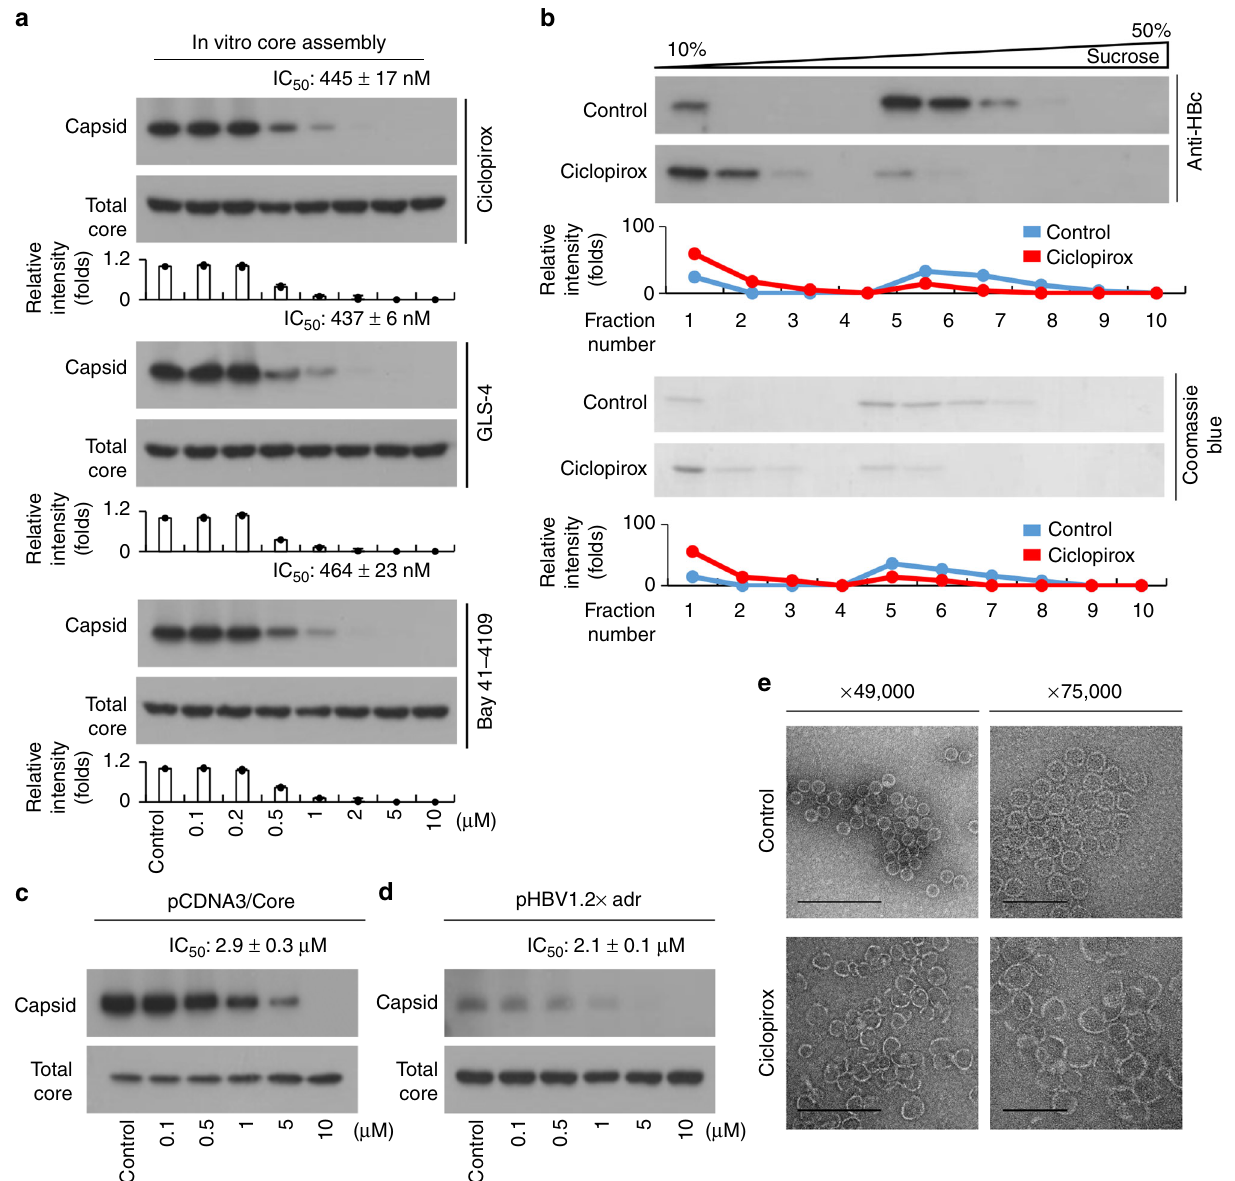
Fig. 2 Ciclopirox inhibits in vitro and intracellular HBV capsid assembly. a Effects of ciclopirox, GLS-4, and Bay41 – 4109 on in vitro HBV capsid assembly. Various concentrations of ciclopirox, GLS-4, or Bay41 – 4109 were mixed with Cp149 in reaction buffer. After 1 h, the mixtures were subjected to a immunoblot analysis with anti-HBV core antibody. b Sucrose density gradient analysis of capsid assembly inhibition by ciclopirox. Ten fractions collected from top to bottom underwent immunoblot analysis. c , d Effect of ciclopirox on intracellular HBV capsid assembly. Huh-7 cells were transfected with ( c ) pCDNA3-Core or ( d ) pHBV1.2× and exposed after 12 h to the indicated concentrations of ciclopirox for 36 h. The cells were lysed and assembled HBV core particles were isolated by sucrose step gradient ultracentrifugation, resolved on 1% agarose gels, and subjected to immunoblot analysis with anti-HBV core antibody. e Electron micrographs of the effect of ciclopirox on in vitro HBV capsid assembly. The particles were negatively stained with 2% uranyl acetate. Scale bars = 200 nm and 100 nm. TEM magni fi cations, ×49,000 and ×75,000. Ciclopirox appeared to convert the T = 4 HBV capsid into T =